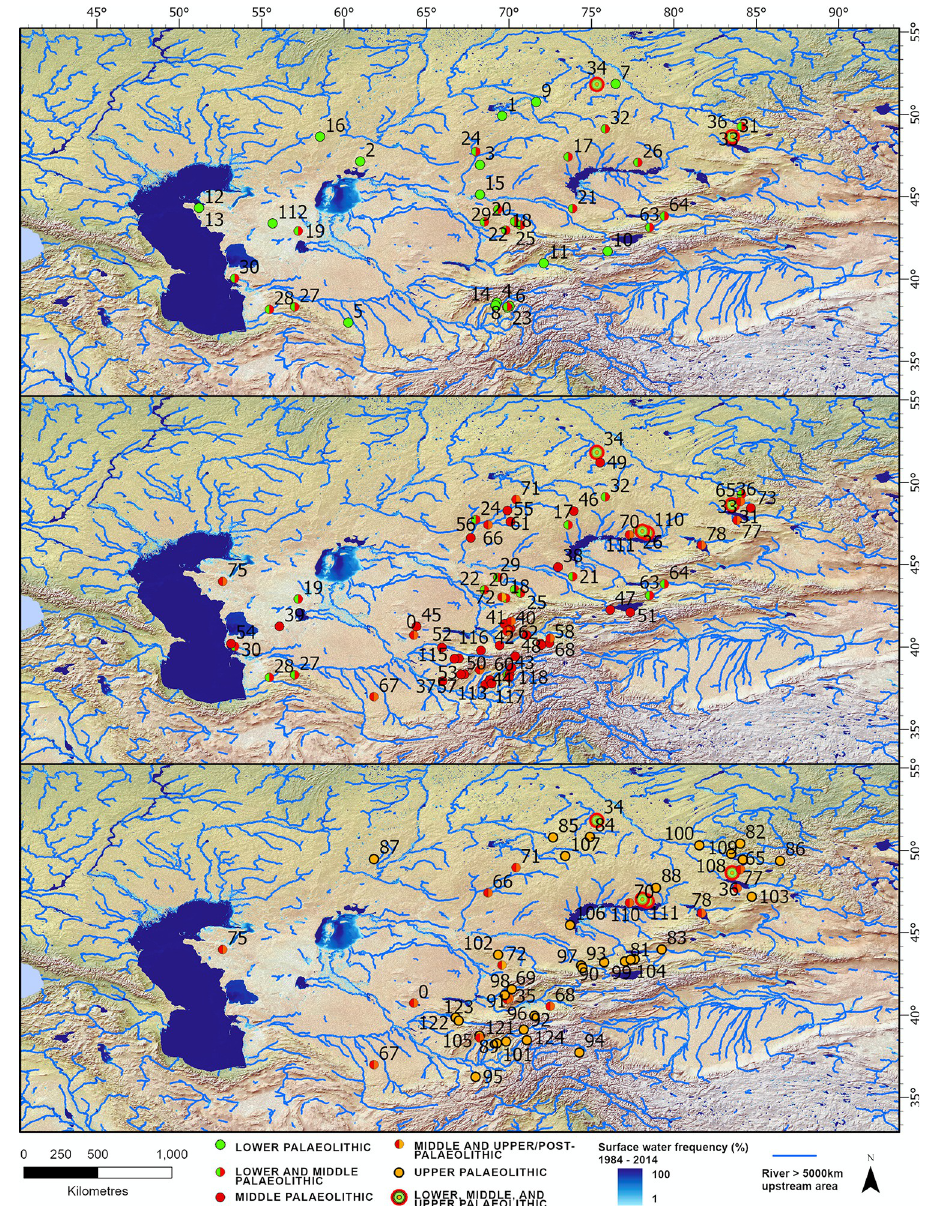
Fig 3. Distribution of Lower Paleolithic (top), Middle Paleolithic (middle) and Upper Paleolithic (bottom) finds. Assemblages that contain multiple paleolithic industries are color-coded accordingly (green = LP, red = MP, orange = UP) and displayed on all applicable maps. Numbers correspond to the sites listed in S1 Table. Surface water [15], and rivers (Hydrosheds [16]) are displayed. Basemap is Natural Earth 2 data. (see Fig 5A). The 780 counted layers show an average growth rate of 71.4 μ m, a typical value for speleothems [112]. The minimum growth rate is 15.8 μ m and the maximum 277.8 μ m. Greyscale values increase from ~391.67 to 391.61 ka BP from around 98 to 148. After that they show a general decreasing trend to lower values until ~391.4 ka BP. During this ~210 year long continuous decline we observe three pronounced decreases at ~391.58, 391.54 and 391.51 ka BP. These shifts to lower values are separated by higher values with a maximum at ~391.55